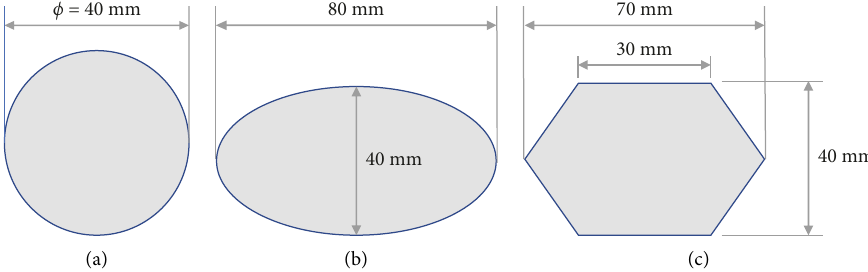
Figure 14: Schematic definition of the cross-sections of the panhead front and rear bars. (a) Rounded edge, (b) elliptic edge, and (c) diamond edge.